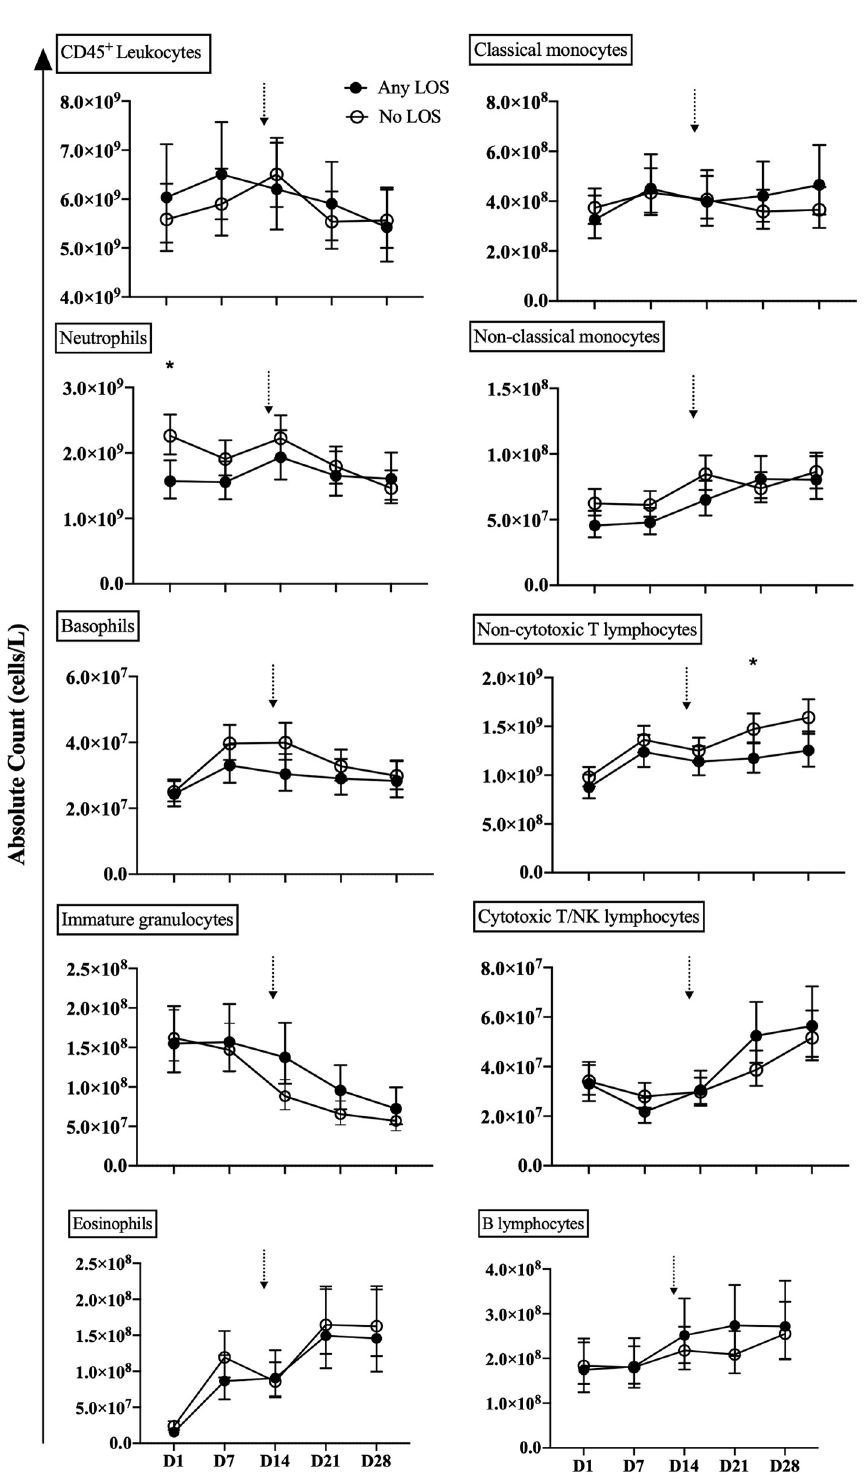
Fig 1. Absolute leukocyte counts. The absolute counts of total leukocyte, granulocyte, monocyte and lymphocyte populations from peripheral blood of preterm infants with any LOS (confirmed and clinical; closed circle) and no LOS (open circle). Analysis was performed by mixed linear regression analysis using a random effects model that was adjusted for known confounders, GA, birth weight z-score, sex and total leukocyte count. Data shown as geometric mean with 95% confidence intervals. Arrows indicate the median age of LOS onset of 13 days in infants in the any LOS